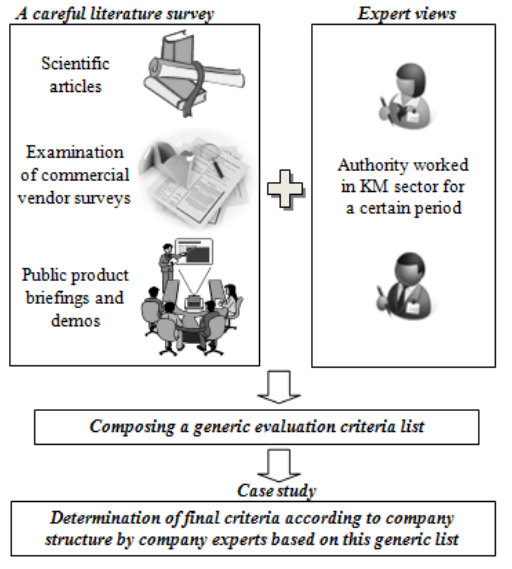
Fig. 1. Criteria determination